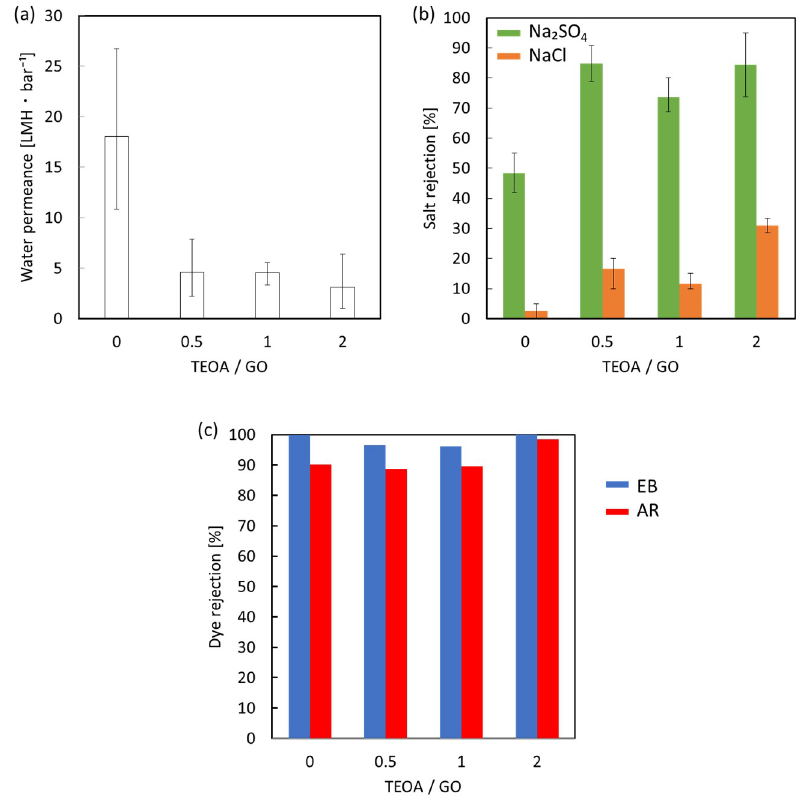
Figure 7. ( a ) Water permeance, ( b ) salt rejection and ( c ) rejection of EB and AR by the unmodified GO membrane and GO-TEOA membranes fabricated with different TEOA/GO ratios.